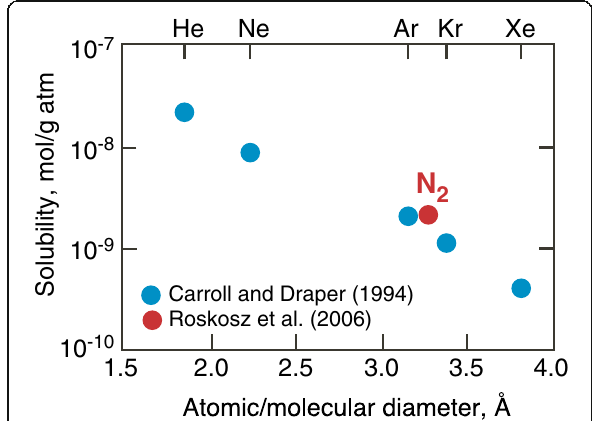
Fig. 15 Nitrogen solubility in basalt melt at ambient pressure shown together with solubility of noble metals as a function of their atomic/molecular radius (data from Carroll and Draper 1994; Roskosz et al. 2006)